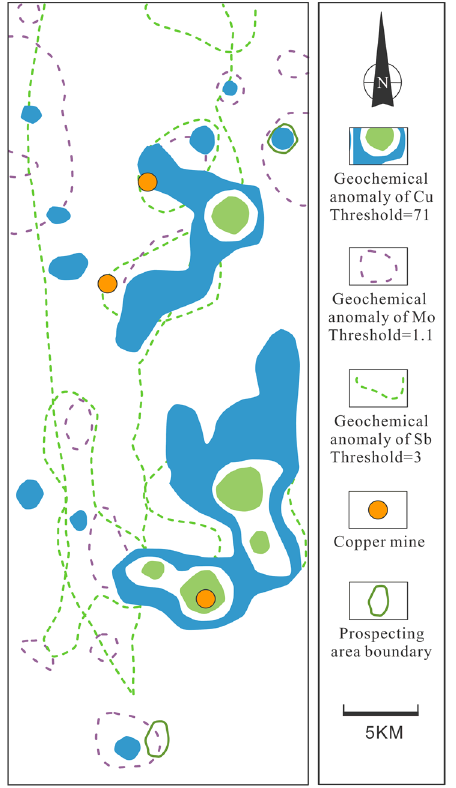
Figure 3. Anomaly map of Cu, Mo, and Sb element combinations (unit: ppm).